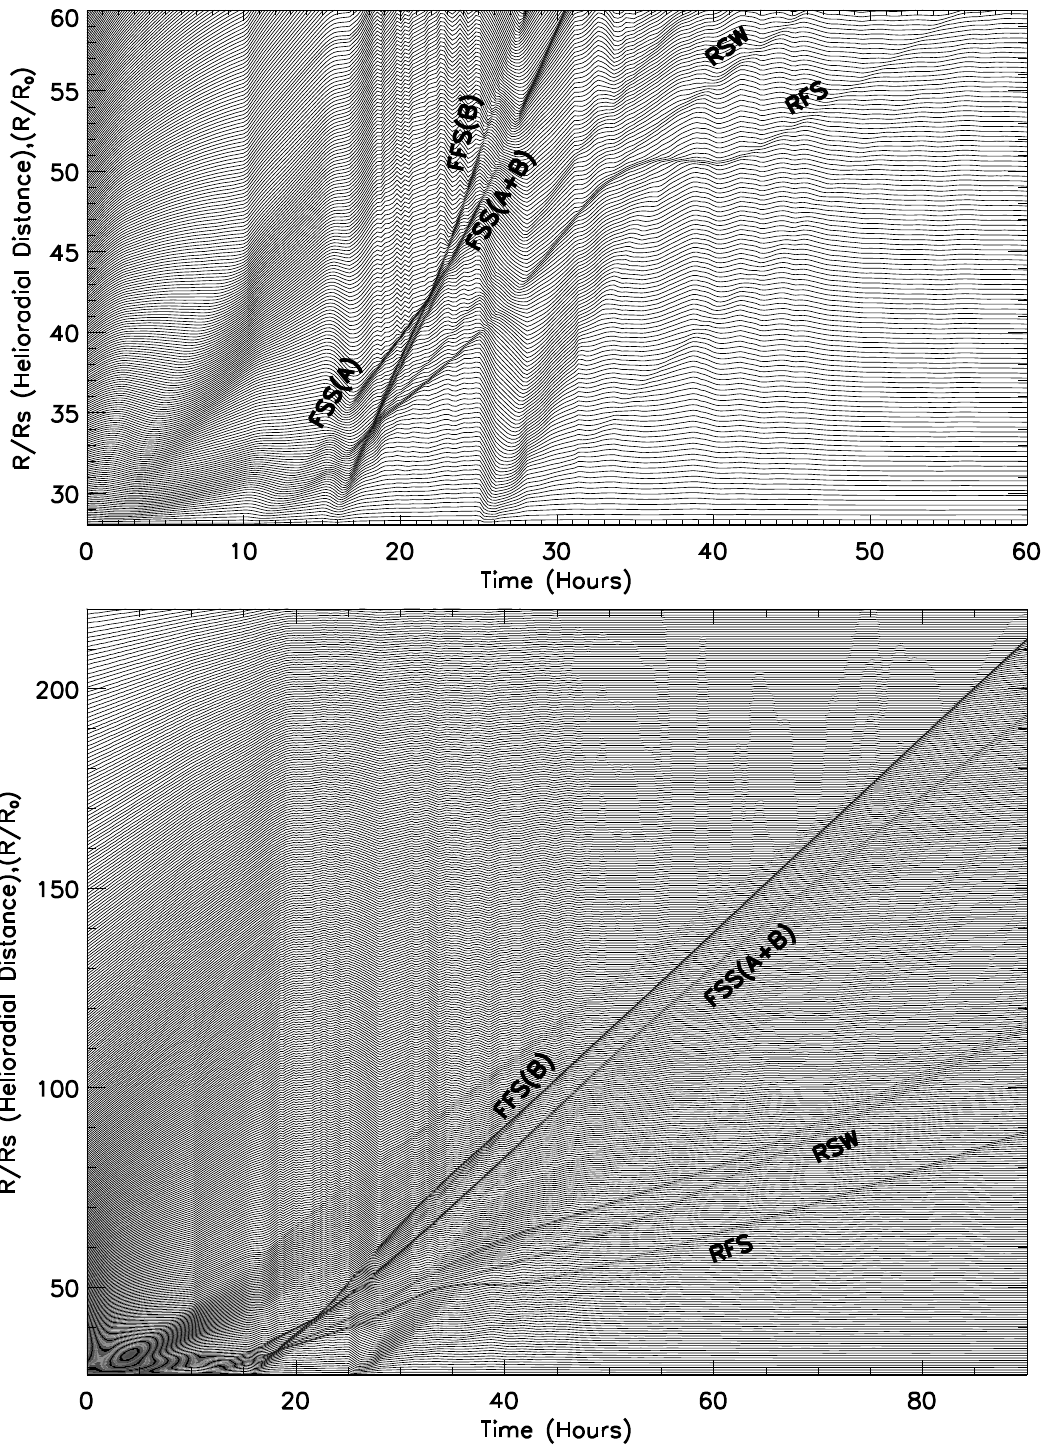
Figure 7. Radius-time profile for Case 3. The upper panel shows the details, from the lower boundary to 60 R (cid:12) , of the various discontinuities (see text), as well as the adaptive grid’s ability for fine tuning the grid sizes. The lower panel shows the continuation of these discontinuities to larger distances.